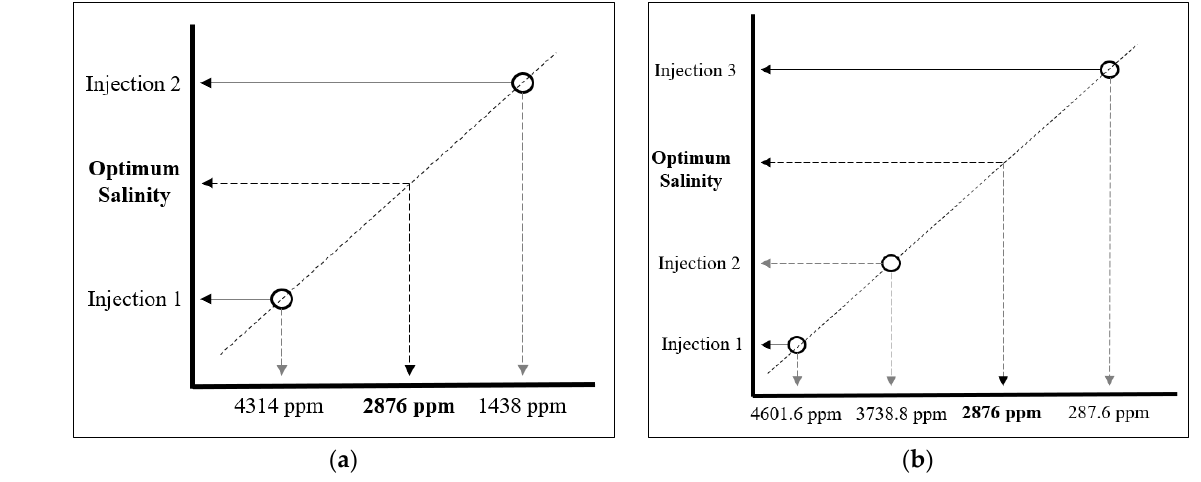
Figure 4. Schematic diagram of negative salinity gradient design for ( a ) CF-2 and ( b ) CF-3. Table 4. Injection brine compositions for negative salinity gradient tests CF-2 and CF-3.